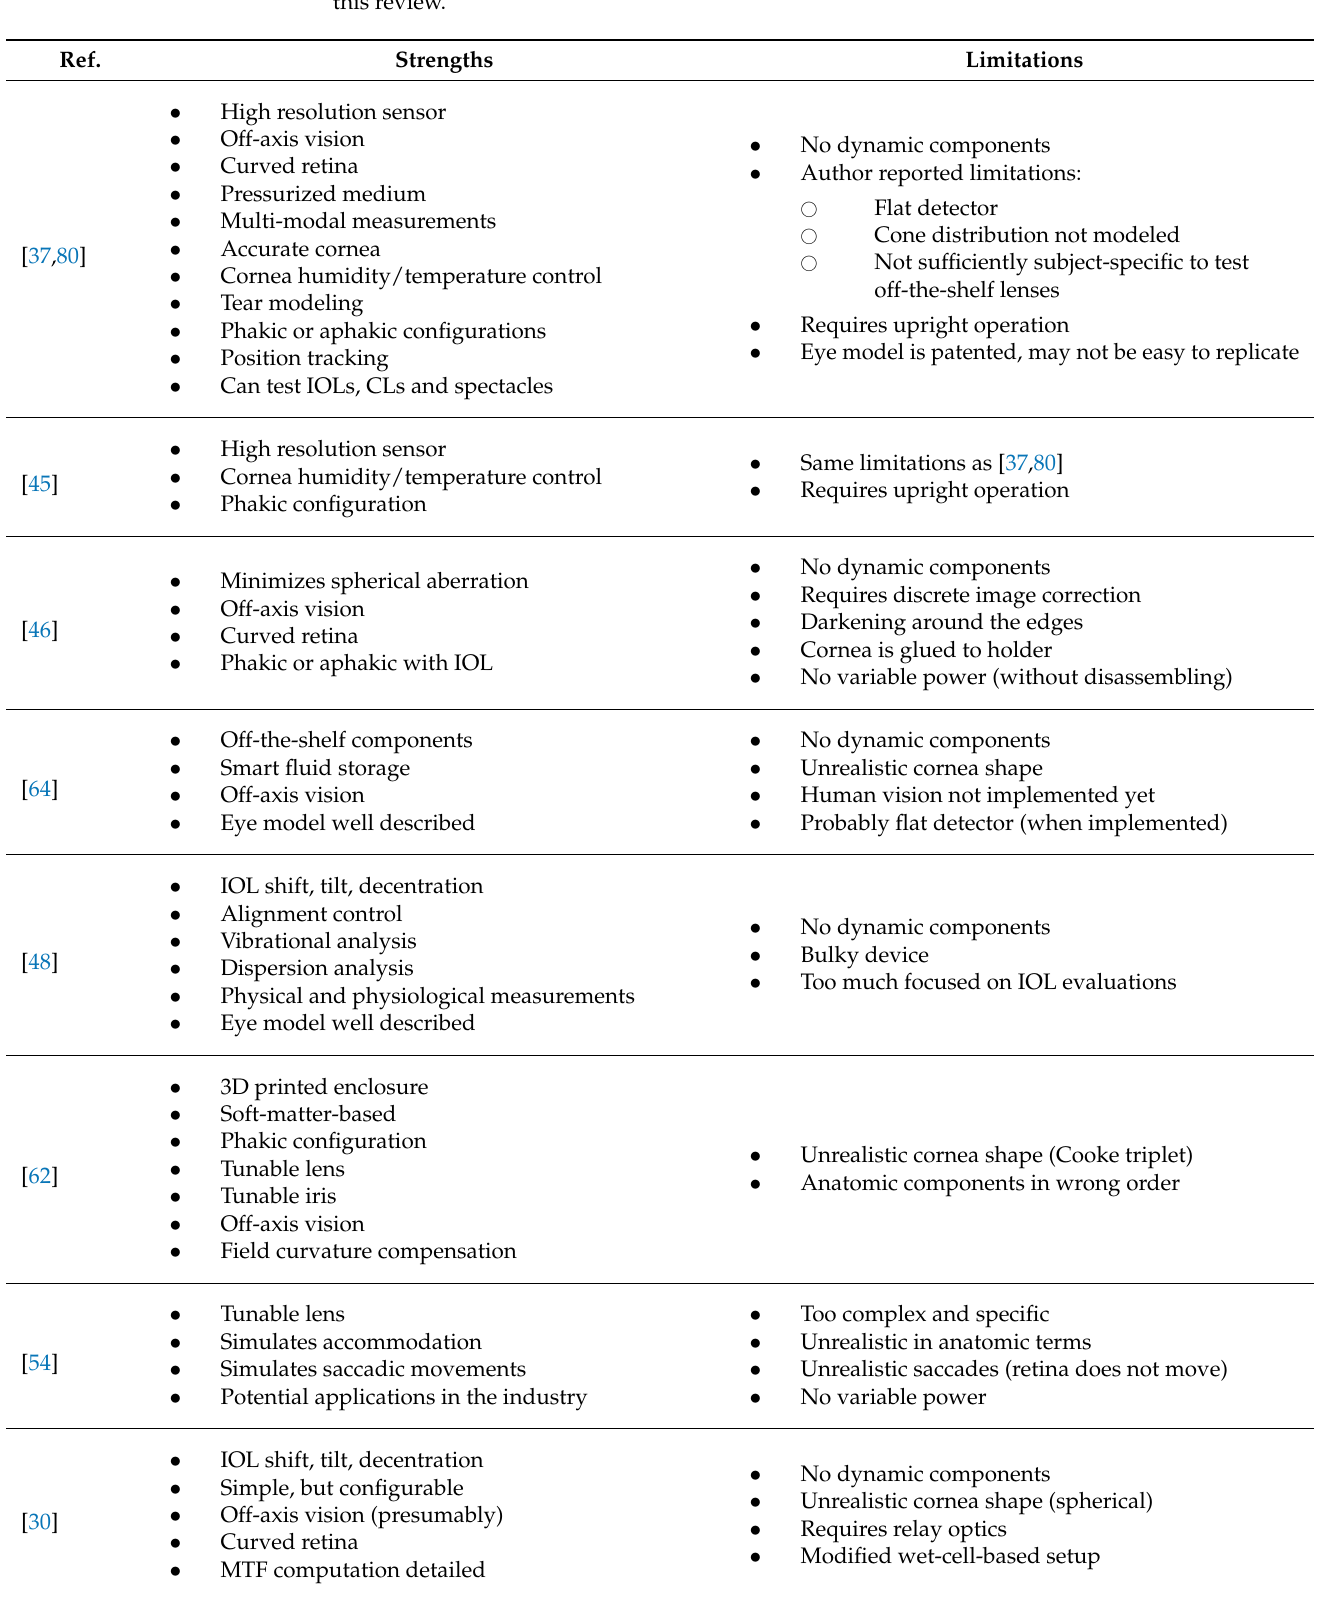
Table 4. Comparison between the single-pass models with image formation features discussed in this